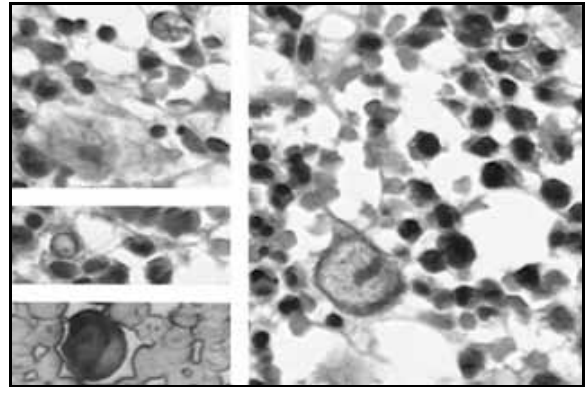
HE: hematoxilina e eosina.